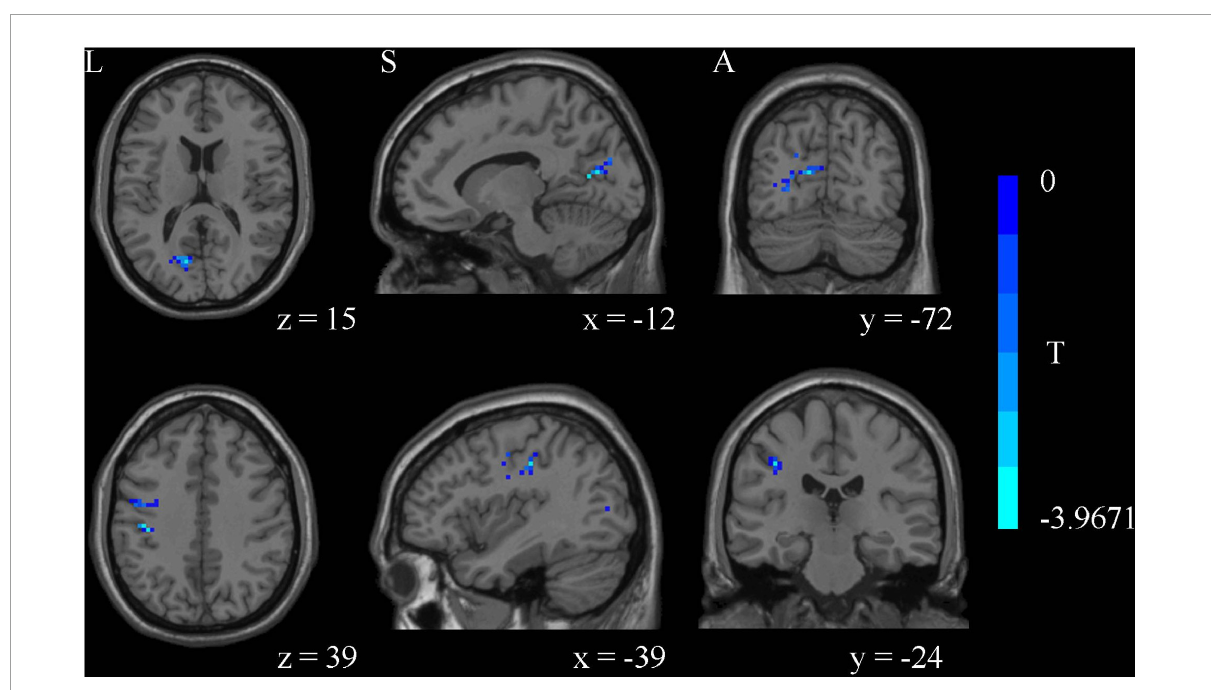
FIGURE1 The amplitude of low frequency fluctuation (ALFF) analysis identified significantly decreased ALFF values of posterior thalamic radiation (PTR) and superior longitudinal fasciculus (SLF) in slow-5 band in major depressive disorder (MDD) compared to healthy controls (HCs).